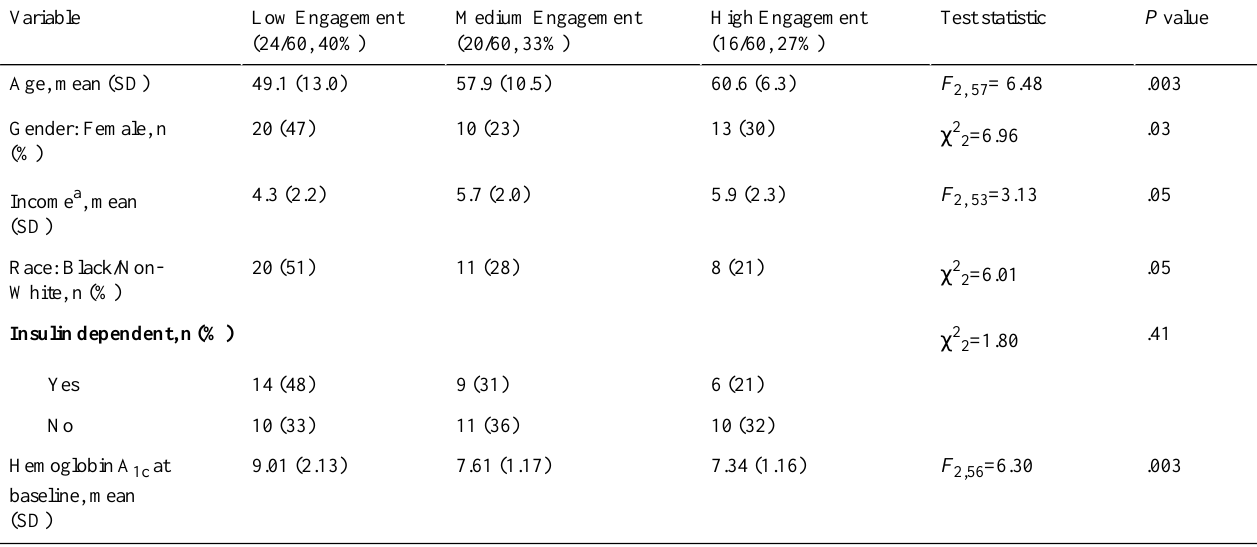
Table 5. Bivariate relationships between baseline demographic and clinical characteristics and engagement group membership.